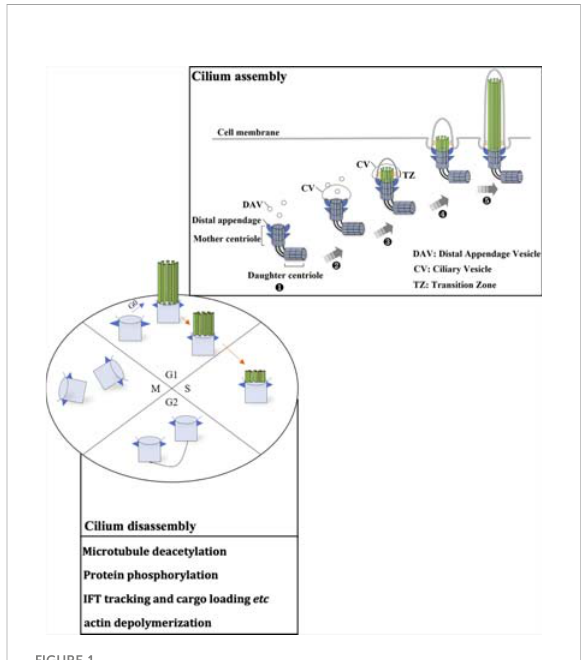
and blue and orange arrows indicate cilium assembly and disassembly, respectively. The mother centriole (light blue cylinder) can initiate ciliogenesis (cilium assembly). (1) Distal appendage vehicles (DAVs, dark blue triangles) accumulate near the distal appendage of the mother centriole. (2) DAVs aggregate and fuse with the mother centriole, forming a ciliary vehicle. (3) Assembly of the transition zone (TZ). (4) The ciliary axoneme (indicated by parallel green rods) covered by CV elongates vertically and fuses with the cell membrane. (5) Extension of the ciliary axoneme and membrane. These microtubule